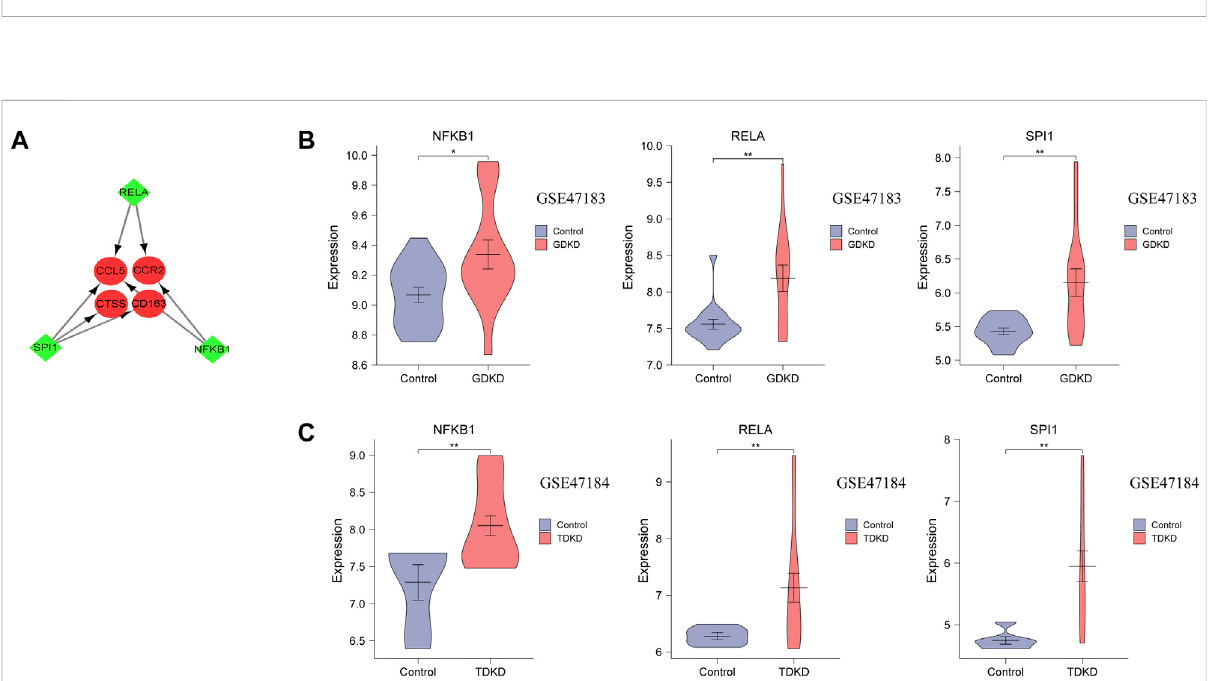
FIGURE 6 mRNA level of hub genes in GSE47I84. All hub genes are upregulated in TDKD samples compared with controls. * p < 0.05. ** p < 0.01, *** p < 0.001. TDKD: tubular diabetic kidney disease.